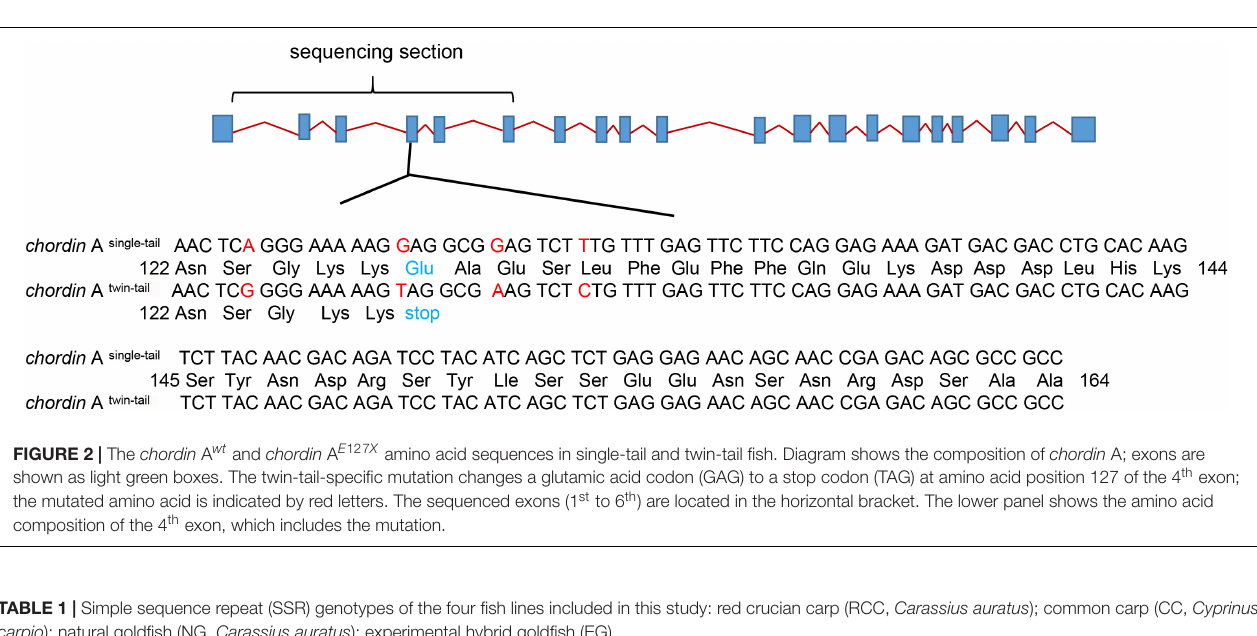
TABLE 1 | Simple sequence repeat (SSR) genotypes of the four fish lines included in this study: red crucian carp (RCC, Carassius auratus ); common carp (CC, Cyprinus carpio ); natural goldfish (NG, Carassius auratus ); experimental hybrid goldfish (EG). Locus RCC CC NG